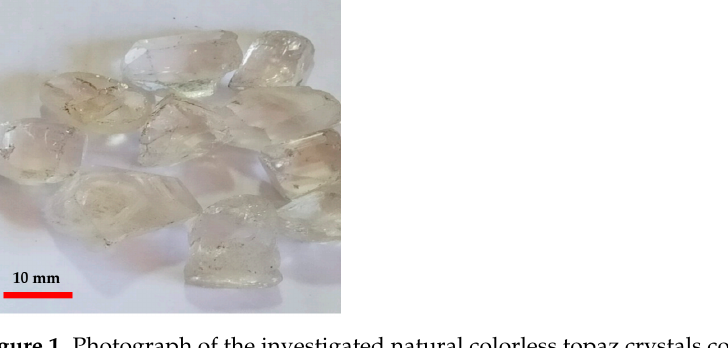
Figure 1. Photograph of the investigated natural colorless topaz crystals collected from Nyit Bruk mine